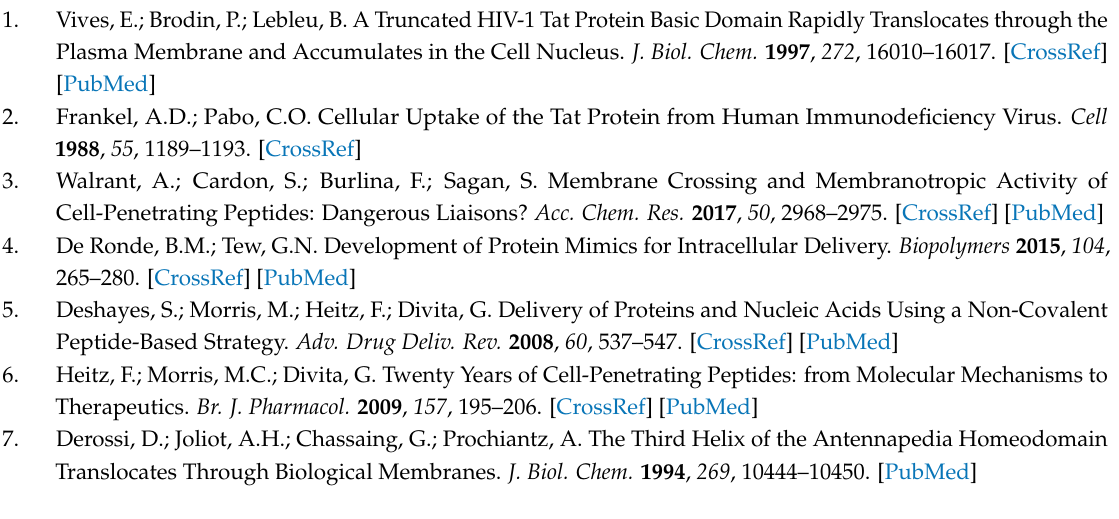
representative overview showing: (A) Correlation coefficient function for PTDM1-only at 10 µ M in PBS (shown again for comparison), Figure S13: Dynamic Light Scattering (DLS) data showing correlation coefficient functions for IgG-FITC antibody (Ab) at 200 nM in PBS with their corresponding intensity-based size distributions, Figure S14: DLS titration data from a second trial of the DLS titration experiment showing correlation functions (left), individual intensity-based size distributions from the results of the three measurements taken per sample (middle), and the averaged intensity-based size distributions shown with ± one standard deviation obtained from the three individual measurements taken of the sample per this second trial, Figure S15: DLS titration data showing number-based size distribution plots (3 measurements per sample) for the starting solution of antibody-only for the two trials, Figure S16: DLS titration data showing number-based size distribution plots (3 measurements per sample) for each step of the titration where the total volume of PTDM1 1 mM DMSO stock solution that had been added up to that point is shown above the plot for both trials, Figure S17: DLS titration data showing number-based size distribution plots (3 measurements per sample) for each step of the titration where the total volume of PTDM1 1 mM DMSO stock solution that had been added up to that point is shown above the plot for both trials, Figure S18: DLS titration data showing number-based size distribution plots (3 measurements per sample) for each step of the titration where the total volume of PTDM1 1 mM DMSO stock solution that had been added up to that point is shown above the plot for both trials., Table S1: IFT values for PTDM1 and surfactants from literature used for creating comparison plots, Table S2: DLS titration experiment concentrations and additions summary